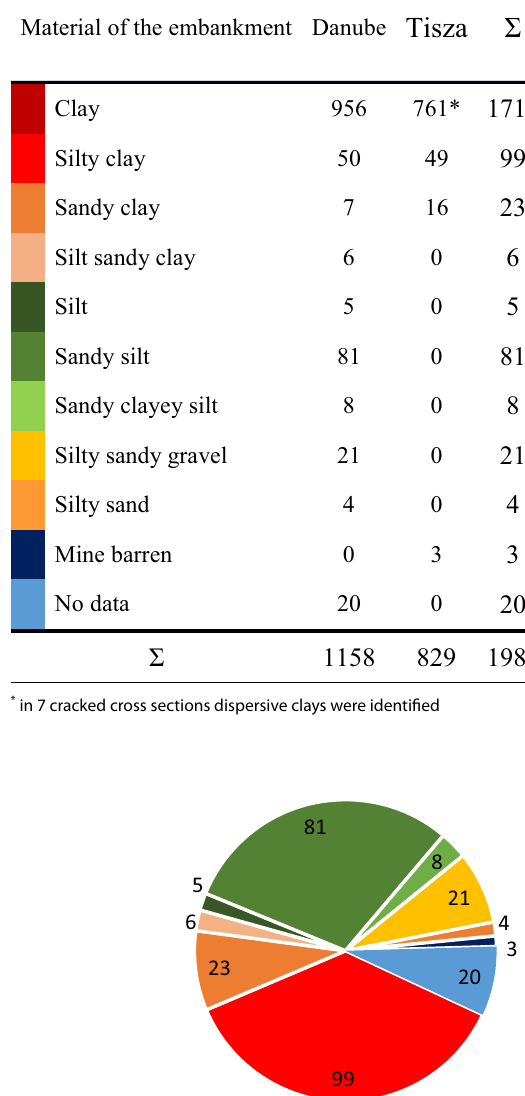
Table 5 Embankment material under the damaged pavement